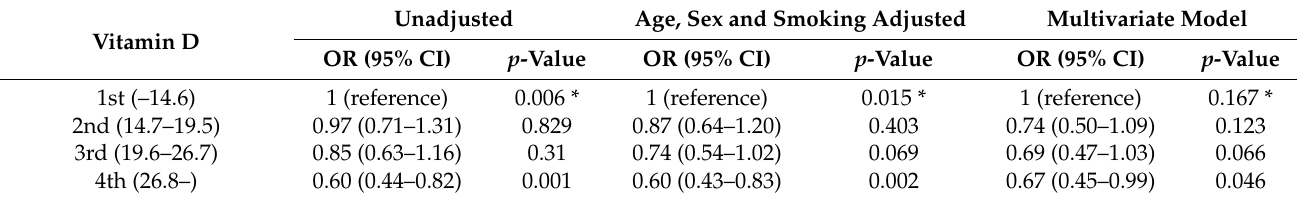
Table 4. Multivariate analysis for the association between vitamin D and MAFLD.